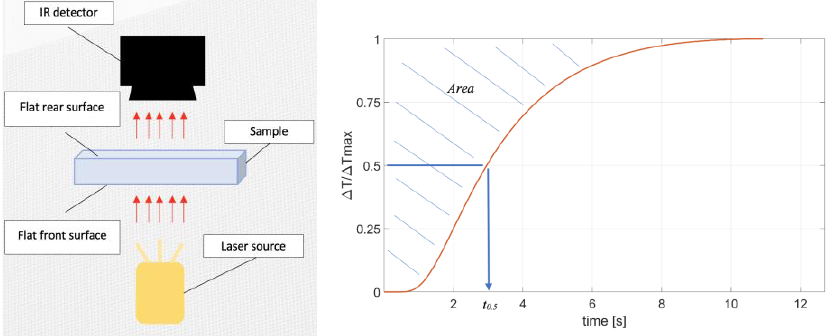
Figure 3. Temperature-rise curve under ideal conditions according to Standard [15].